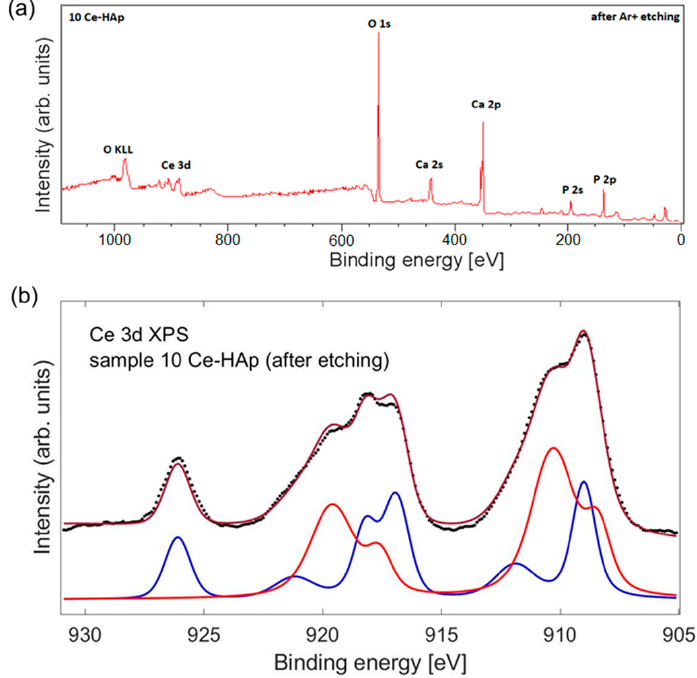
Figure 7. XPS spectra ( a ) and XPS spectrum of Ce (3d) regions ( b ) of the 10Ce-HAp coating after etching. Upper spectra: Data (points) and total fit (brown line) to date after subtraction of a linear background; Lower spectra: The dashed line represents Ce 3+ (red line) and the dotted line represents Ce 4+ (blue line).